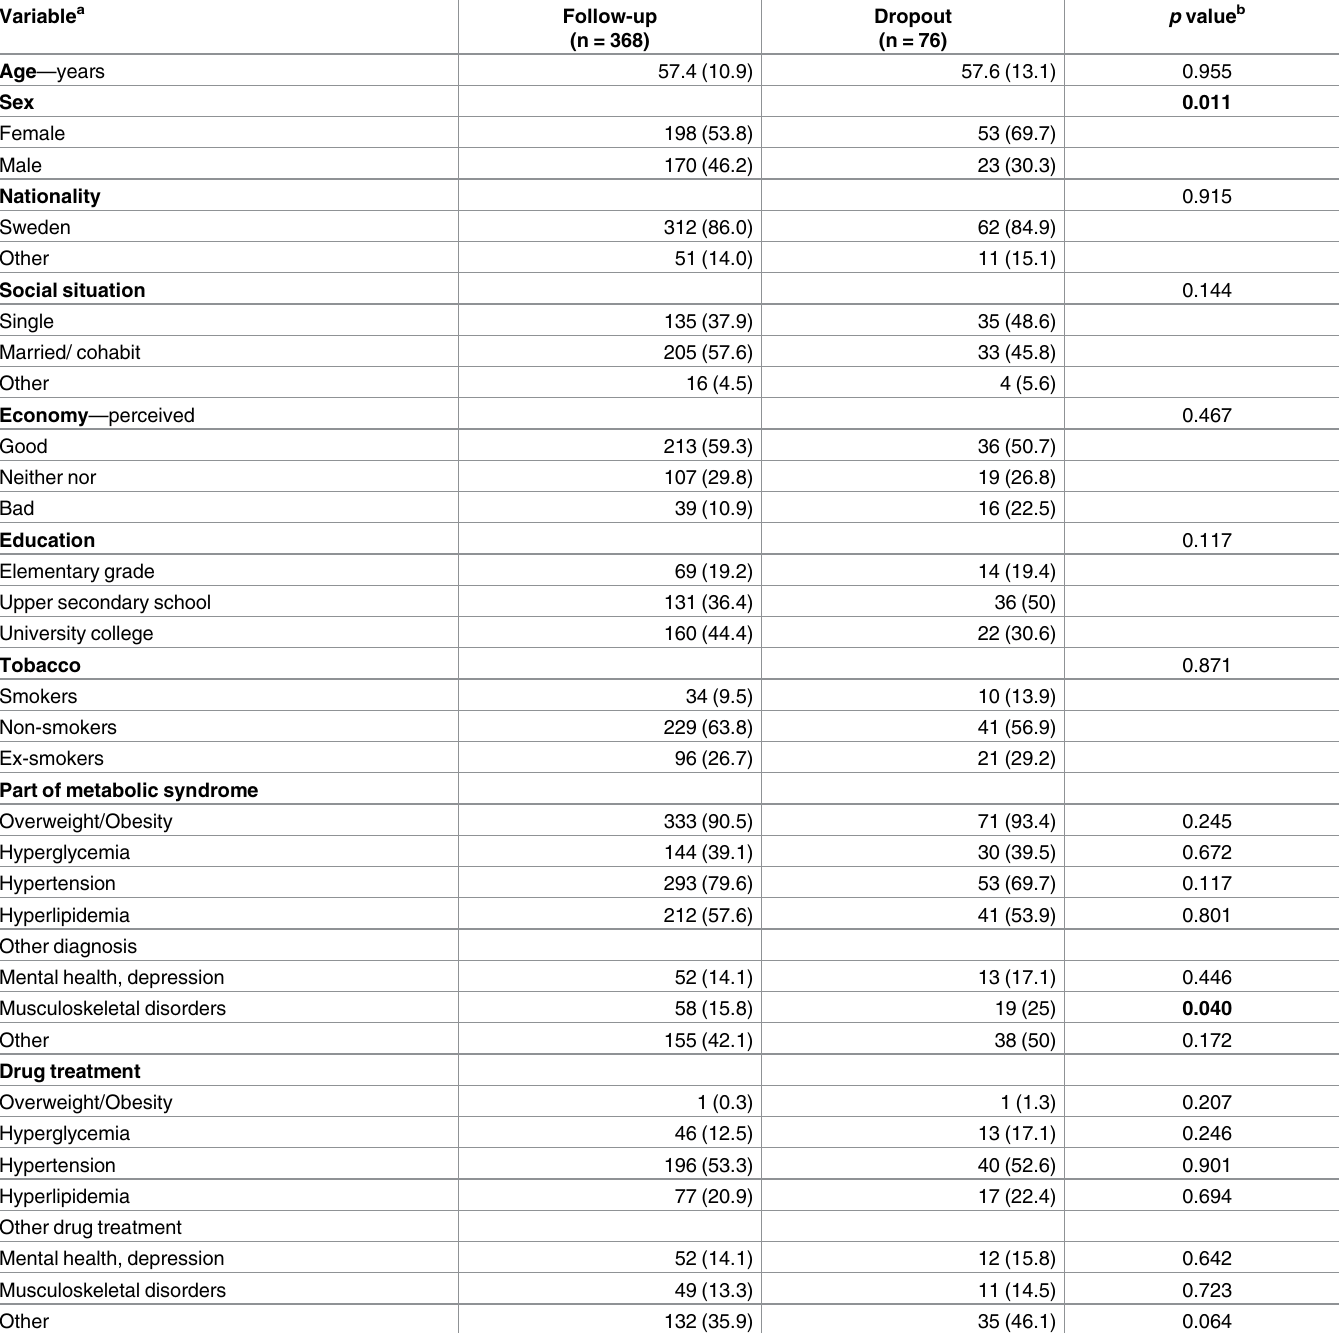
Table 1. Baseline characteristics of the follow-up and dropout